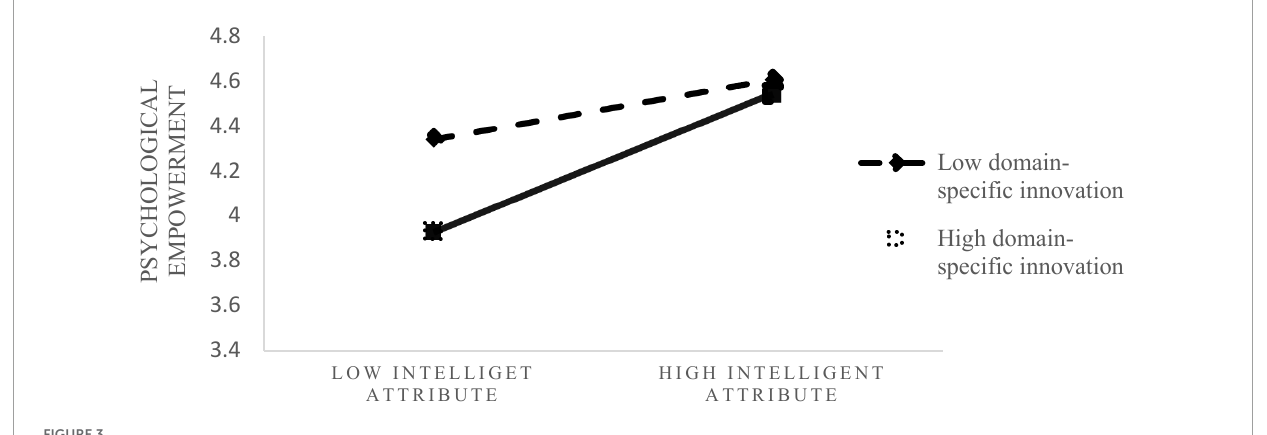
FIGURE3 The moderating role of Consumer domain-specific innovation between intelligence attribute and psychological empowerment.